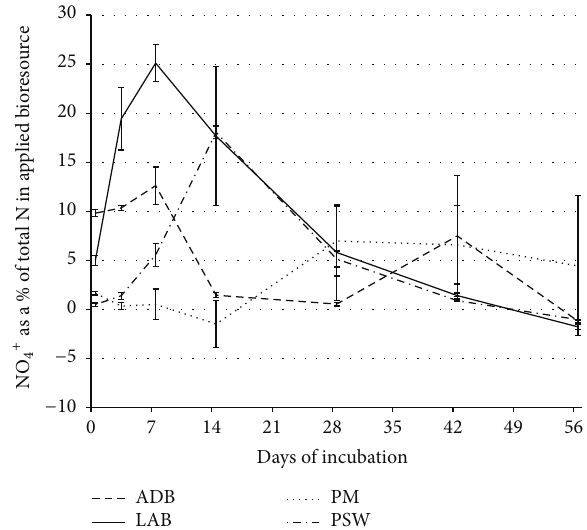
Figure 1: NO 3− concentration of treated soils (dry weight) as a percentage of total N of added amendment (error bars are standard error of the means). Corrected for NO 3− in control soil.